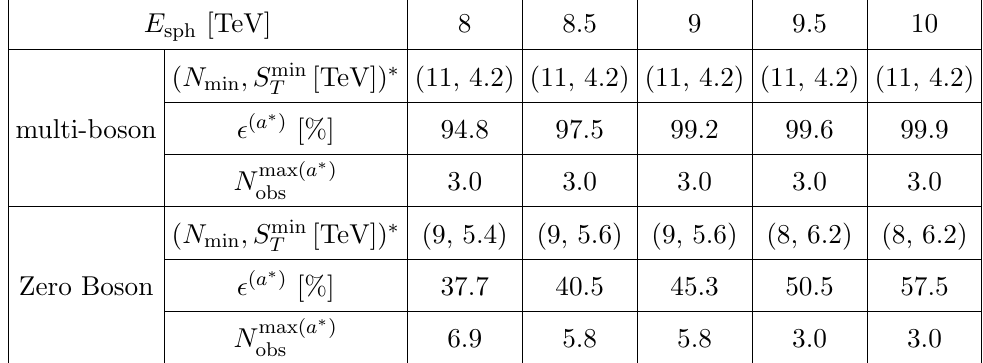
) (cid:3) ), the signal e(cid:14)ciency ( (cid:15) ( a (cid:3) ) ) at signal T (cid:3) ) ) are shown for di(cid:11)erent values obs